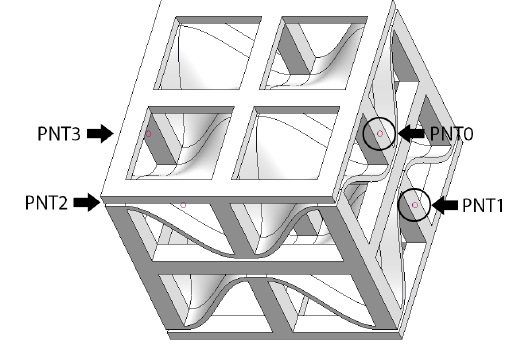
Figure 8. Evolution of the force needed to deform the model according to longitudinal deformation of the structure with T 1 = 1 mm; T 2 = 3 mm and L = 12